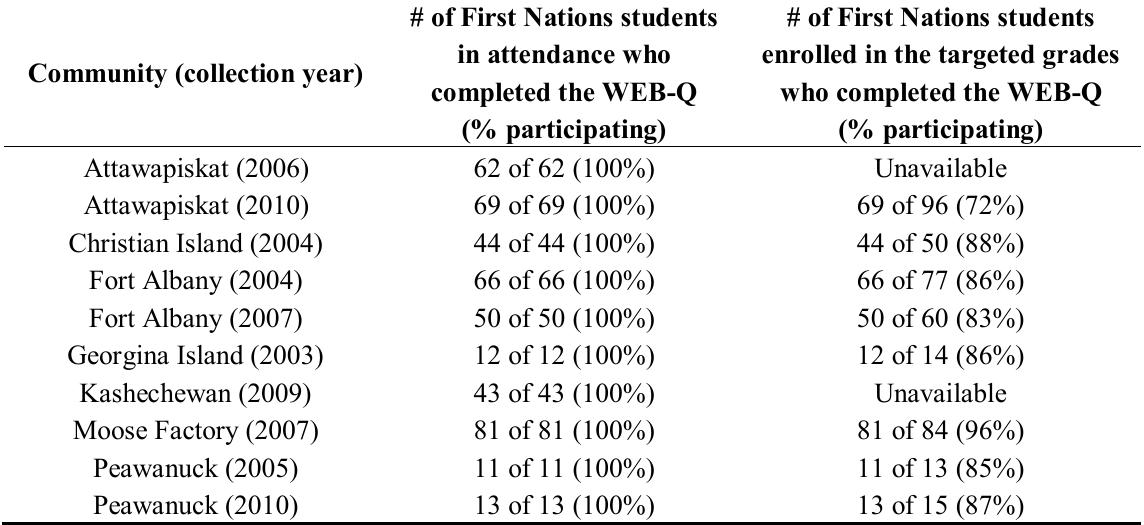
Table 3. Number and percentage of school-aged children who participated in the study by